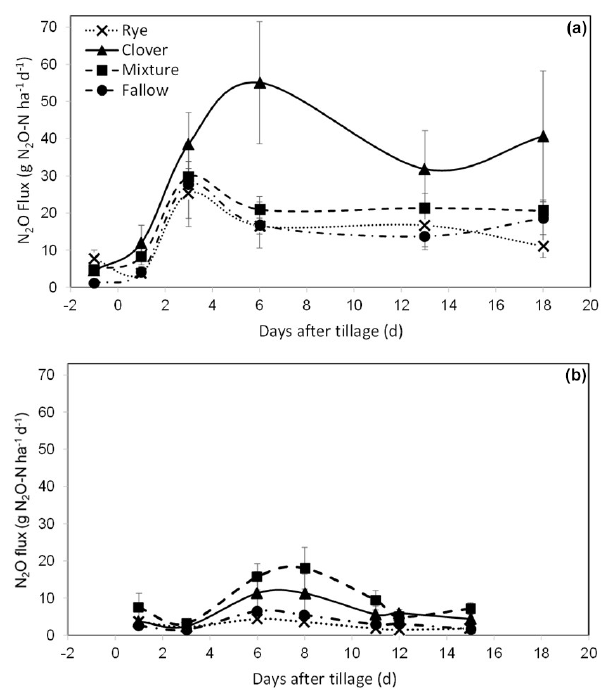
Figure 2. (a) Mean net nitrous oxide (N 2 O) flux from the soil (with standard error) over 18d at CF, measured once the day be- fore ( d = − 1) tillage on 23 May 2018 ( d = 0) and then five times following tillage and incorporation of cover crop biomass. (b) Mean net nitrous oxide (N 2 O) flux from the soil (with standard error) over 15d at KBS, measured seven times following tillage on 26 May 2020 ( d = 0). The lines connecting the sampling points are intended to aid in visualizing treatment patterns for cumulative N 2 O and do not indicate continuous data collection (Eq.